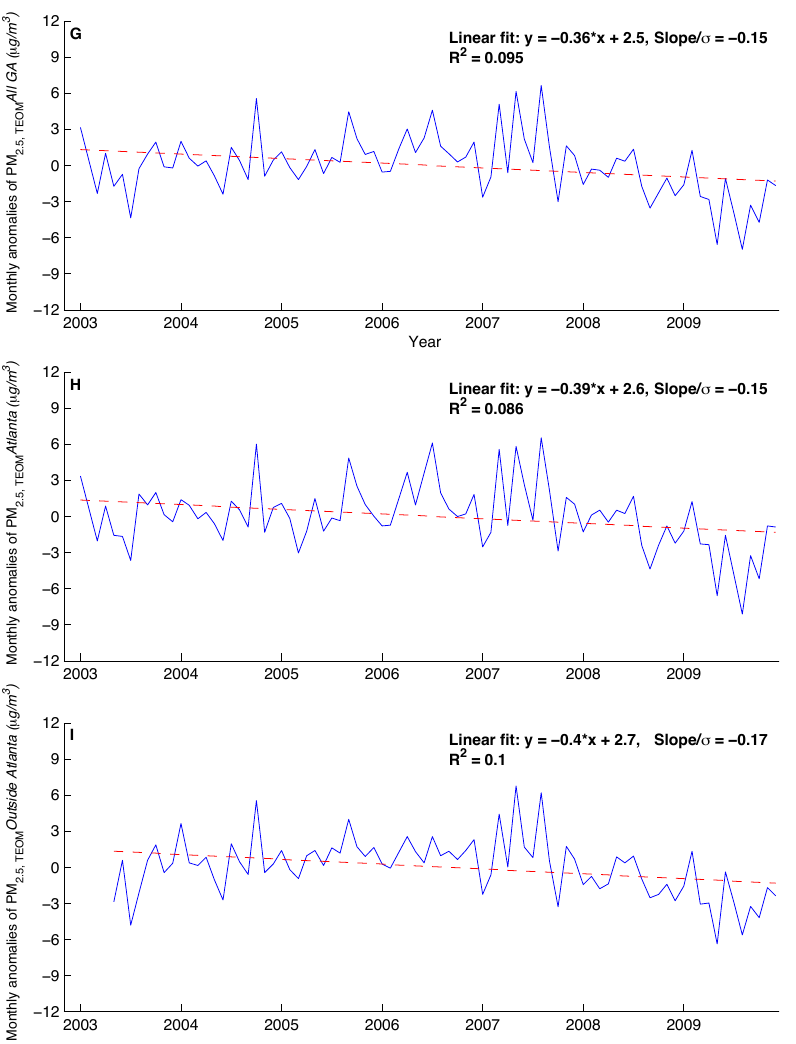
Fig. 9c. (G–I) Time series of monthly anomalies for PM 2 . 5 , TEOM AllGA , PM 2 . 5 , TEOM Atlanta and PM 2 . 5 , TEOM OutsideAtlanta . The units for all PM 2 . 5 are µgm − 3 . Dashed red lines denote linear regression trend lines (see Table 1). Linear regression equations, linear fit statistics and normalized slopes=slope/standard deviation ( σ ) are